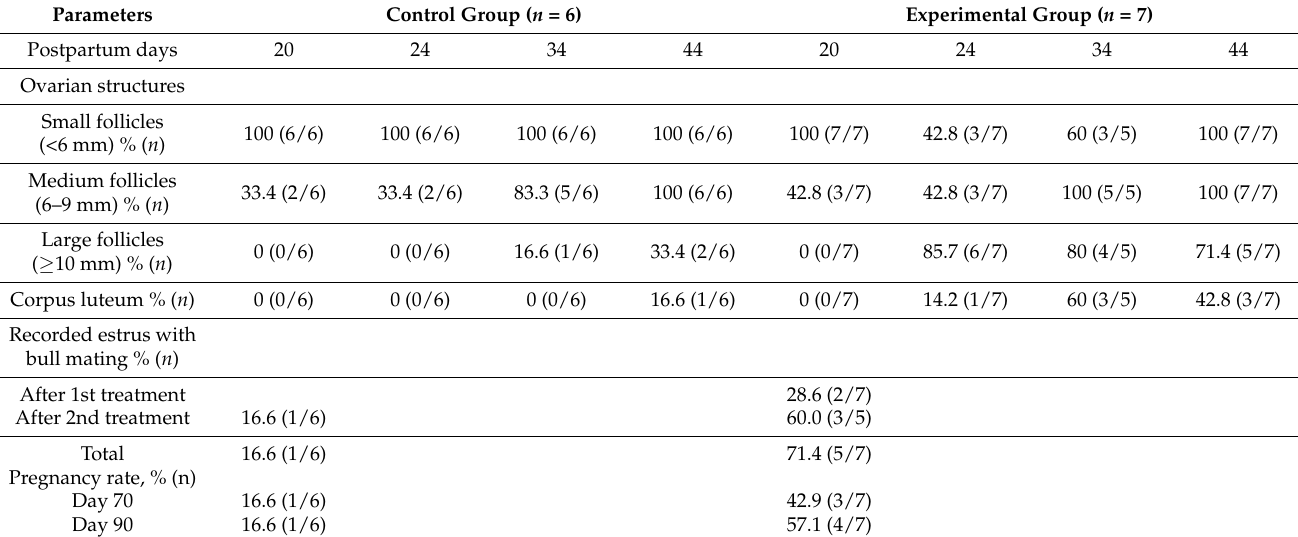
Table 5. Ovarian structures, estrus expression, and pregnancy rate in control and experimental Bulgarian Murrah buffaloes. Parameters Control Group ( n = 6) Experimental Group ( n = 7) Postpartum